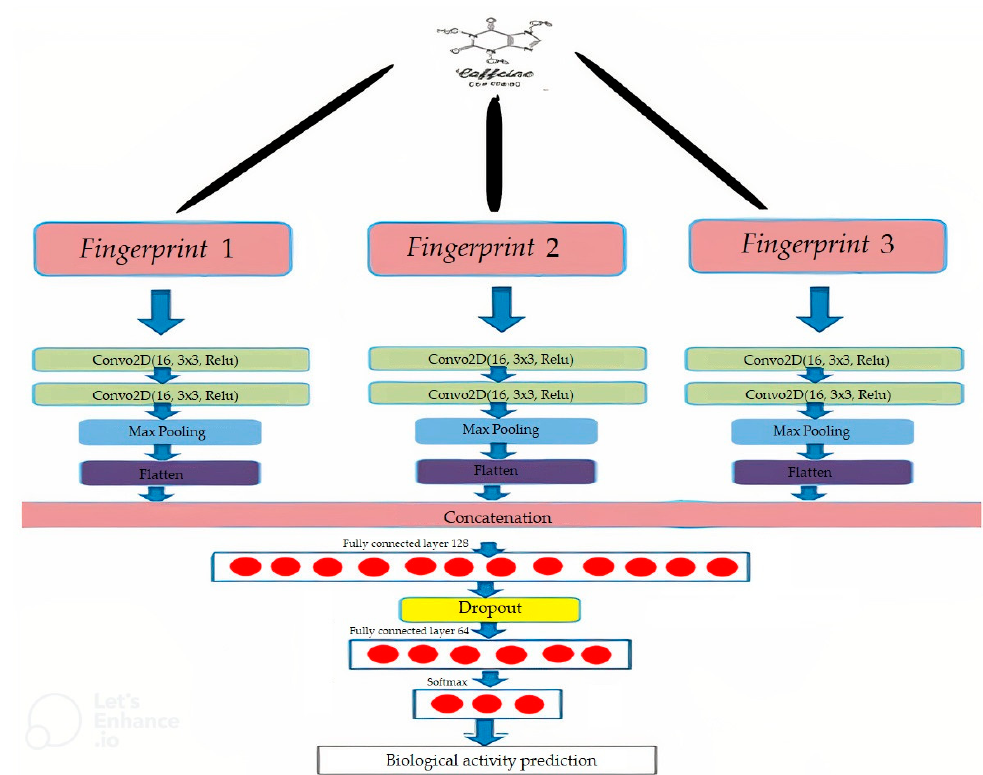
Figure 20. The configuration of the combined CNN that was used for 3